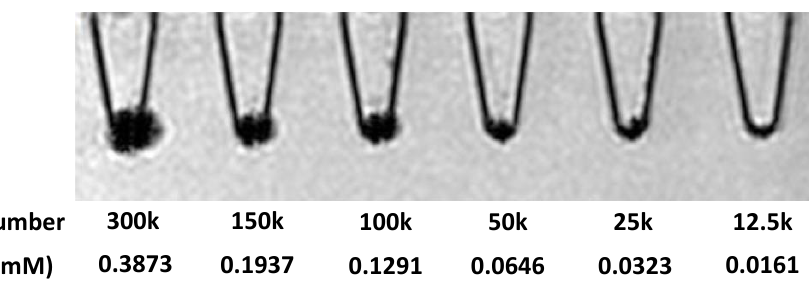
Figure 4. Cell viability of U87MG cells as determined by MTT assay 24 h after incubation with each composite for 5 h. The concentration of plasmid pEGFP-C1 pDNA of all composites was fixed at 0.5 μg/well. The amount of lipofectamine was fixed at 2.0 μg/well.